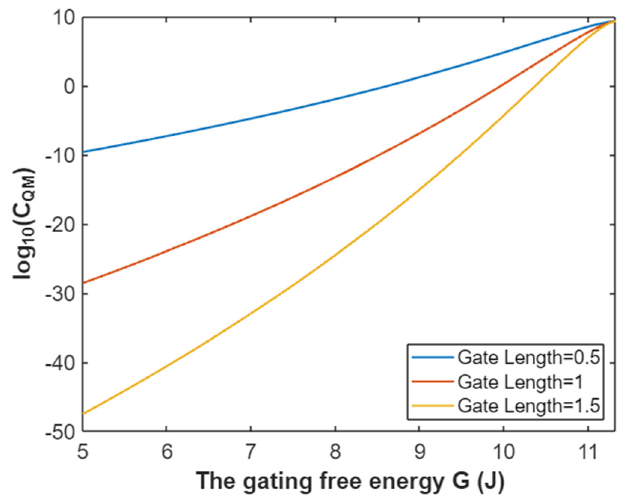
Figure 31. The relationship between gating free energy and the common logarithm of the quantum membrane conductance of extracellular potassium at membrane potential of 0.087 V and over a gating free energy range from 5 J to 11.33 J.